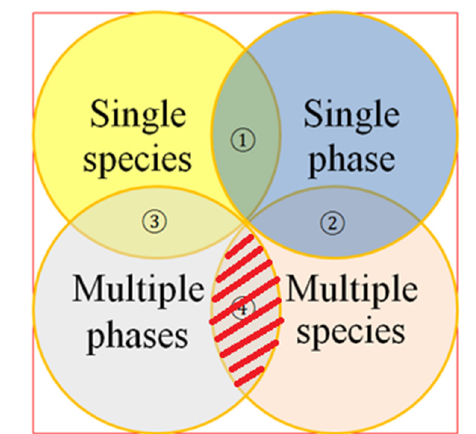
Figure 2. Categories of ionic transport models in concrete: (1) single phase, single species model, (2) single phase, multi ‐ species model, (3) multi ‐ phase, single species model, and (4) multi ‐ phase, multispecies transport model (“double multi” model). Adapted from